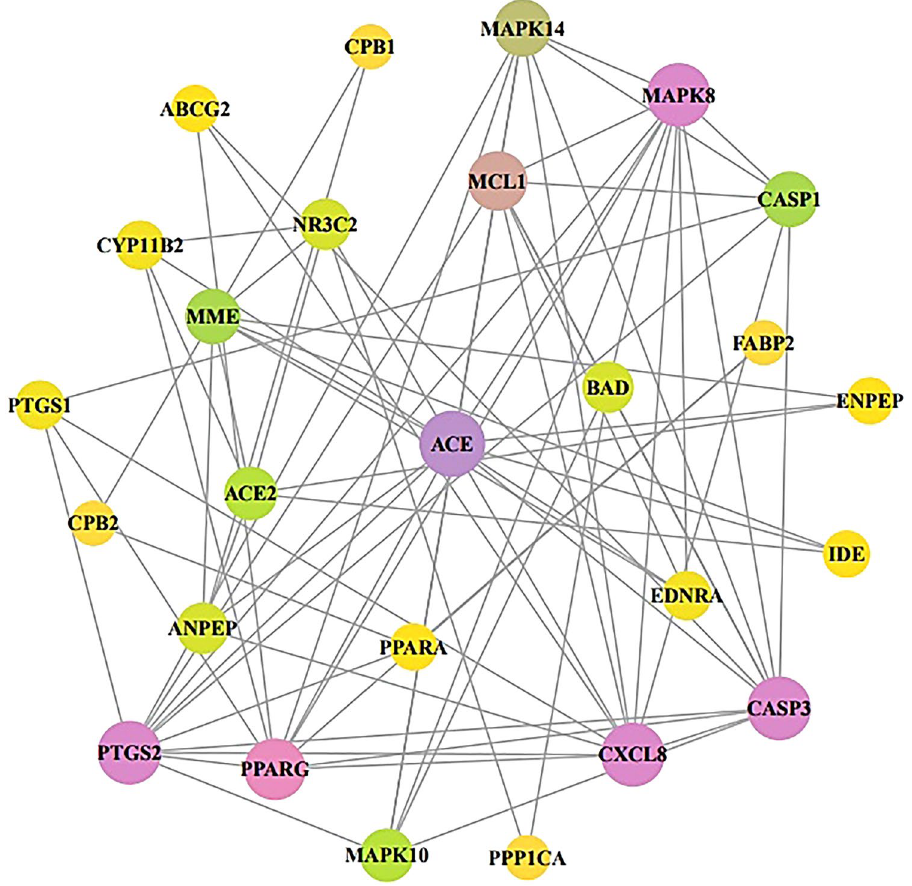
Figure 4. Protein protein interaction (PPI) networks with 26 nodes and 78 edges in NSAIDs against COVID- 19 via STRING analysis. Node: the number of units; Edge: the number of interactions between the